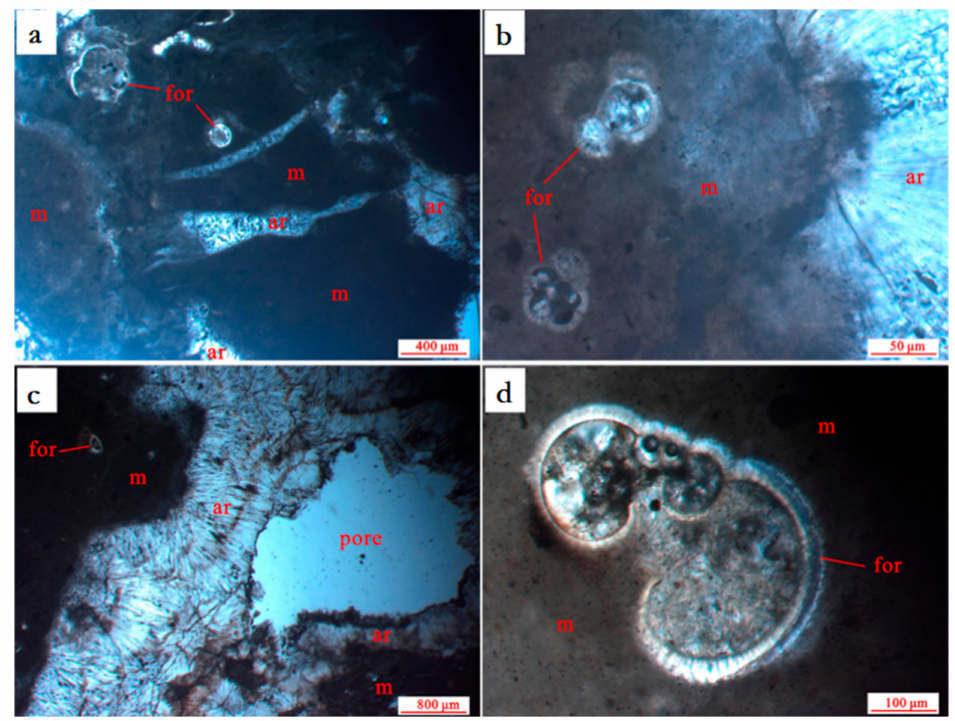
Figure 3. Thin-section photomicrographs of carbonate samples. ( a , b ) Sample at 52.1 mbsf. ( c , d ) Sample at 53.6 mbsf. m: micrite; ar: aragonite; for: foraminifer; and pore: pore space.